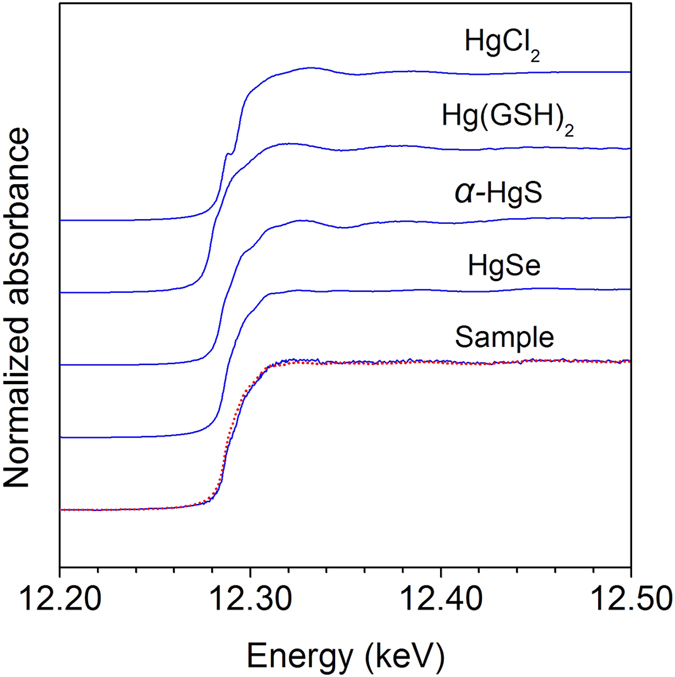
Hg LIII XANES spectra of the soil sample (100 mg Hg kg–1 and 150 mg Se kg–1) and the reference compounds (HgCl2, α-HgS, Hg-Glutathione (RS-Hg-SR) and HgSe).The red dot line demonstrated the highly consistent of the XANES spectrum of soil sample with that of HgSe compound.